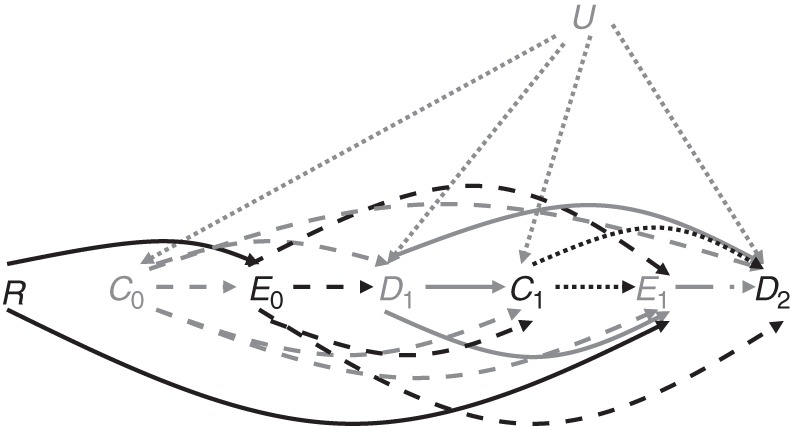
Directced acyclic graph illustrating associations between randomized trial group (R), time-dependent covariates at time t (Ct, e.g., CD4 cell count), switch to second-line antiretroviral therapy (ART) before/at time t (Et), death before/at time t (Dt), and unmeasured common causes of C and D (U) among human immunodeficiency virus–positive patients on ART. Arrows represent direct causal relationships between variables. Time-dependent covariates (C) at a given time point influence whether treatment is switched to second-line ART at that time point or subsequently (E) and influence time-dependent covariates (C) at later time points and mortality (D). Switching treatment regimens (E) influences time-dependent covariates (C), switching (E), and mortality at later time points (D). The following assumptions are made: R has no effect on C other than via E; R has no effect on D other than via E; there are no unmeasured common causes of E and C or E and D; and R is randomized. Different line styles and colors are used only to distinguish the effects of randomized group, different covariates, exposures, and death: Effects of R are shown by solid black lines; effects of C0 by dashed gray lines; effects of E0 by dashed black lines; effects of D1 by solid gray lines; effects of C1 by dotted black lines; effects of E1 by dashed-dotted gray lines; and effects of U by dotted gray lines.